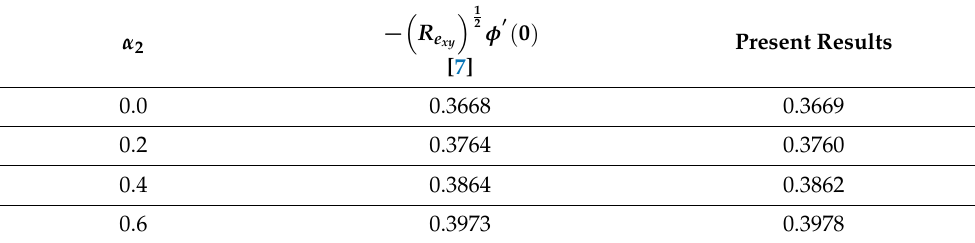
Table 4. Comparative investigation for mass transfer rate against α 2